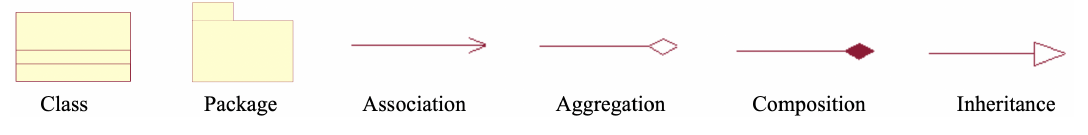
Figure 3. The graphical symbols of UML class